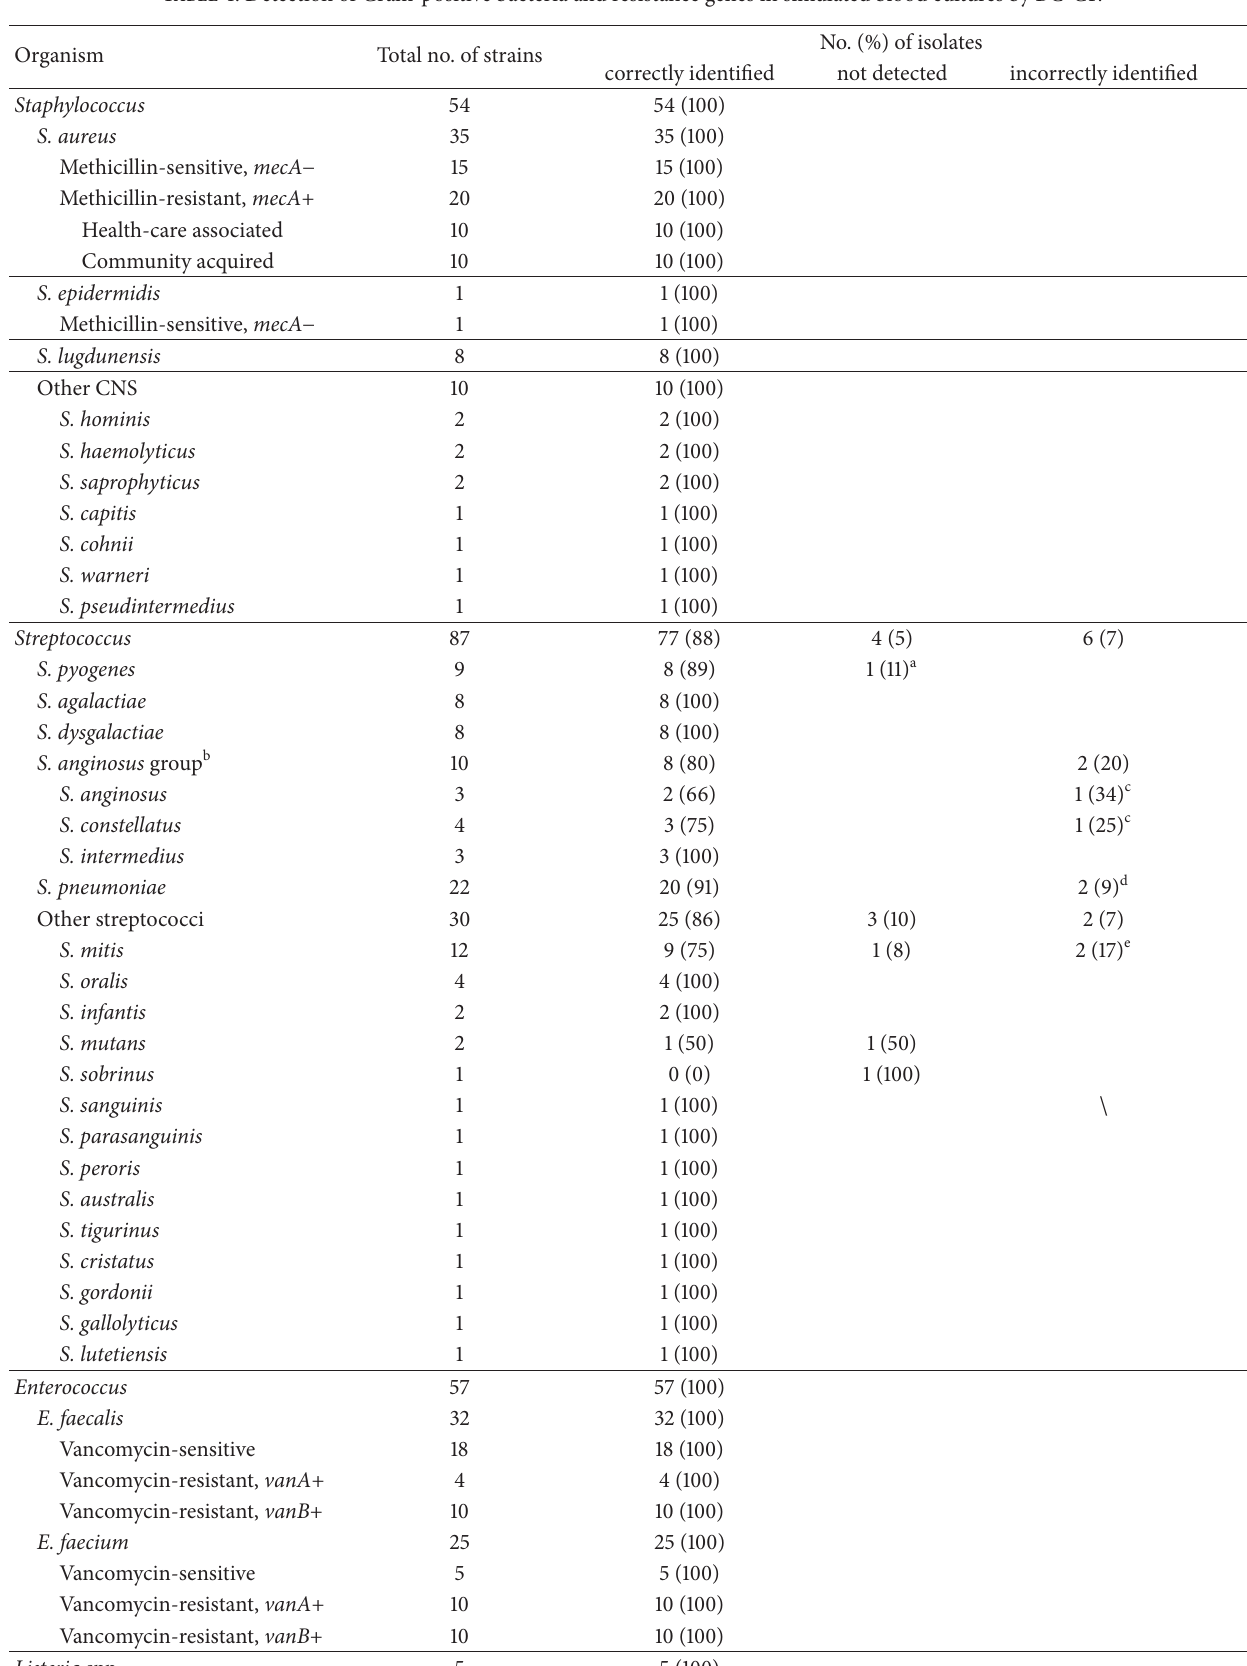
Table 4: Detection of Gram-positive bacteria and resistance genes in simulated blood cultures by BC-GP. Organism Total no. of